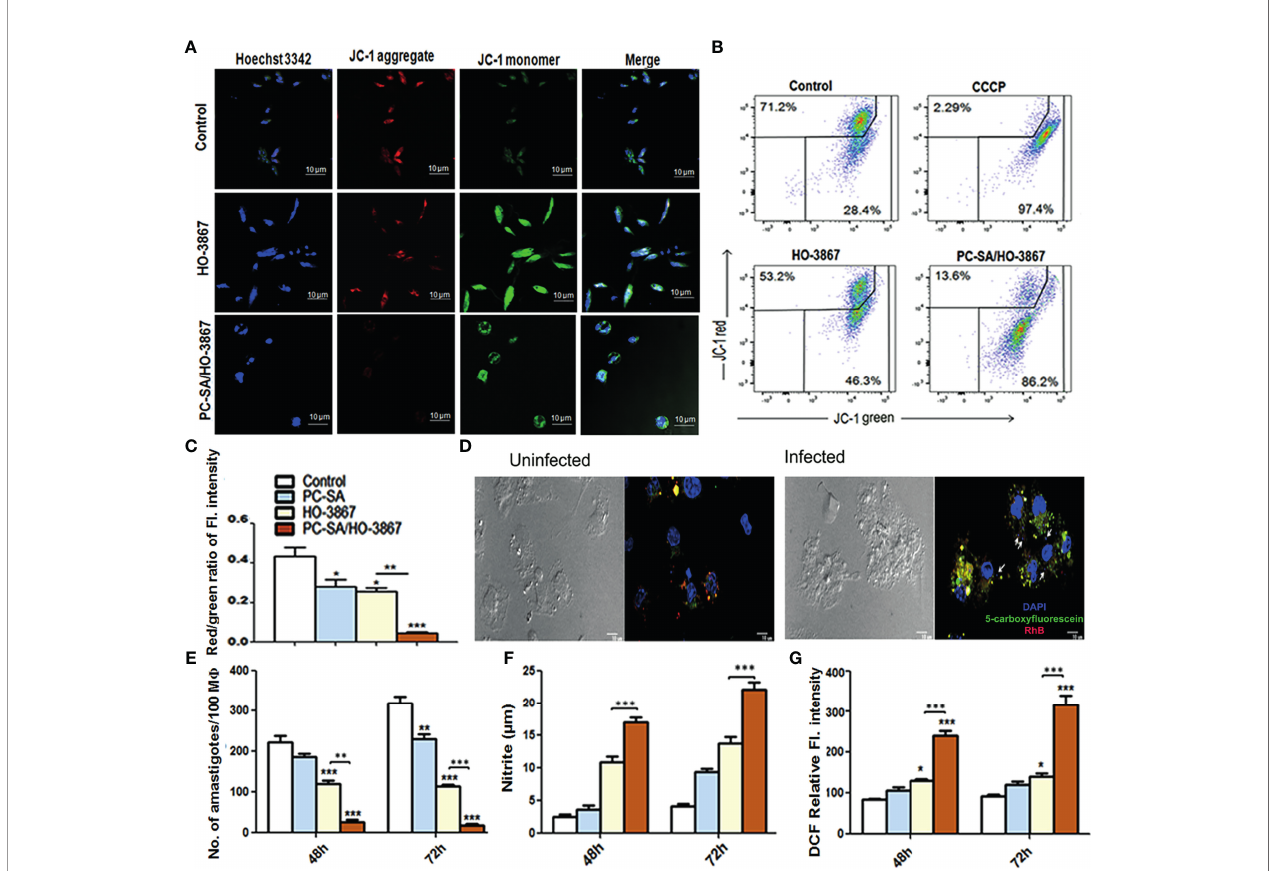
FIGURE 4 | In vitro leishmanicidal effect of liposomal HO-3867. (A – C) In situ mitochondrial membrane potential of promastigotes after a 2-h treatment with or without liposomal HO-3867, as estimated by JC-1 staining. An almost complete JC-1 monomer was induced by 50 µM CCCP, uncoupling mitochondrial respiration, taken as positive control. Confocal images (A) , fl ow cytometry dot plot (B) , and the bar graph (C) intensity of red/green JC-1 ratio. (D) Internalization of fl uorescent PC-SA liposomes (membrane stained with red RhB encapsulating the green 5-carboxy fl uorescein stain inside core) inside the uninfected (i and in vitro L. donovani - infected (ii) peritoneal M F from healthy BALB/c mice. Intact PC-SA liposomes (yellow) are seen near macrophage nuclei (blue). White arrows indicate intracellular L. donovani amastigotes (small blue dots). Magni fi cation, ×40. Data are representative of three independent experiments with similar results. (E) Intracellular parasite burden in peritoneal M F from naïve BALB/c mice infected with promastigotes treated with HO-3867 (10 µg/ml), PC-SA/HO-3867, and empty PC-SA liposomes (10 µg/ml w.r.t PC) for 48 and 72 h post infection, expressed as number of amastigotes/100 M F s in the form of bar graph. NO (F) and ROS (G) production by the treated M F after 48 and 72 h in response to in vitro infection. Data (mean ± S.E.) are derived from the three independent experiments with similar results. * p < 0.05, ** p < 0.001, *** p < 0.0001 compared to saline control as assessed by one-way ANOVA and Tukey ’ s multiple-comparison